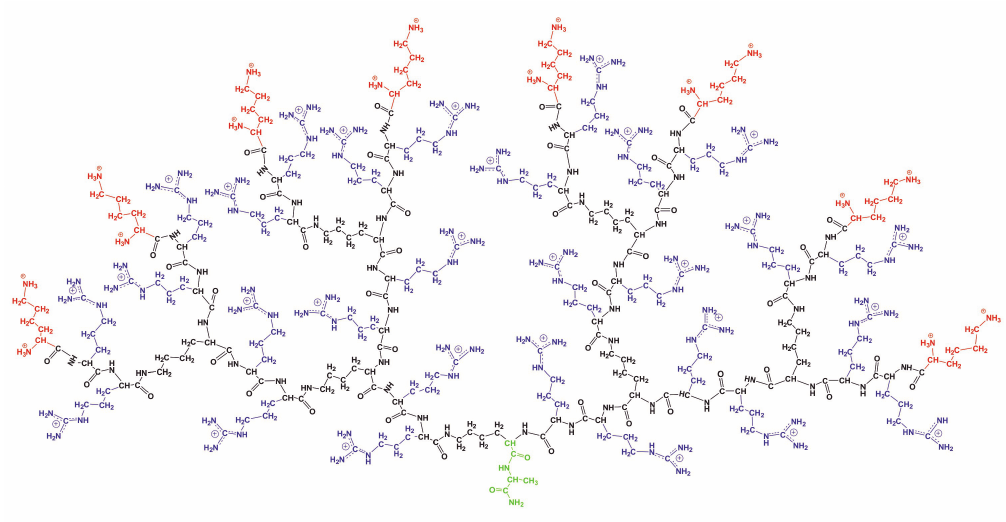
Figure 1. The chemical structure of the Lys-2Arg dendrimer. The dendrimer core is marked by green color, the backbone by black color, the side Arg segments by violet color and the terminal lysine segments by red color. Table 1. The characteristics of Lys-2Arg dendrimer: the molecular mass M , the charge Q bare , the number of terminal NH + groups N end and their charge Q end , also the number N ins and the charge Q ins of 3 inserted aminoacid residues, and the total number N H of water molecules in the system. 2 O Dendrimer M (g/mol) Q bare